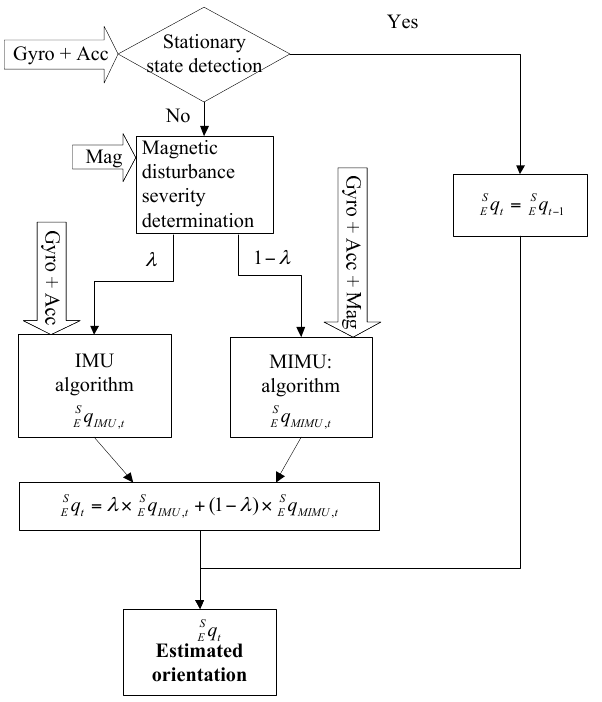
Figure 1. Overview of the proposed method’s structure.